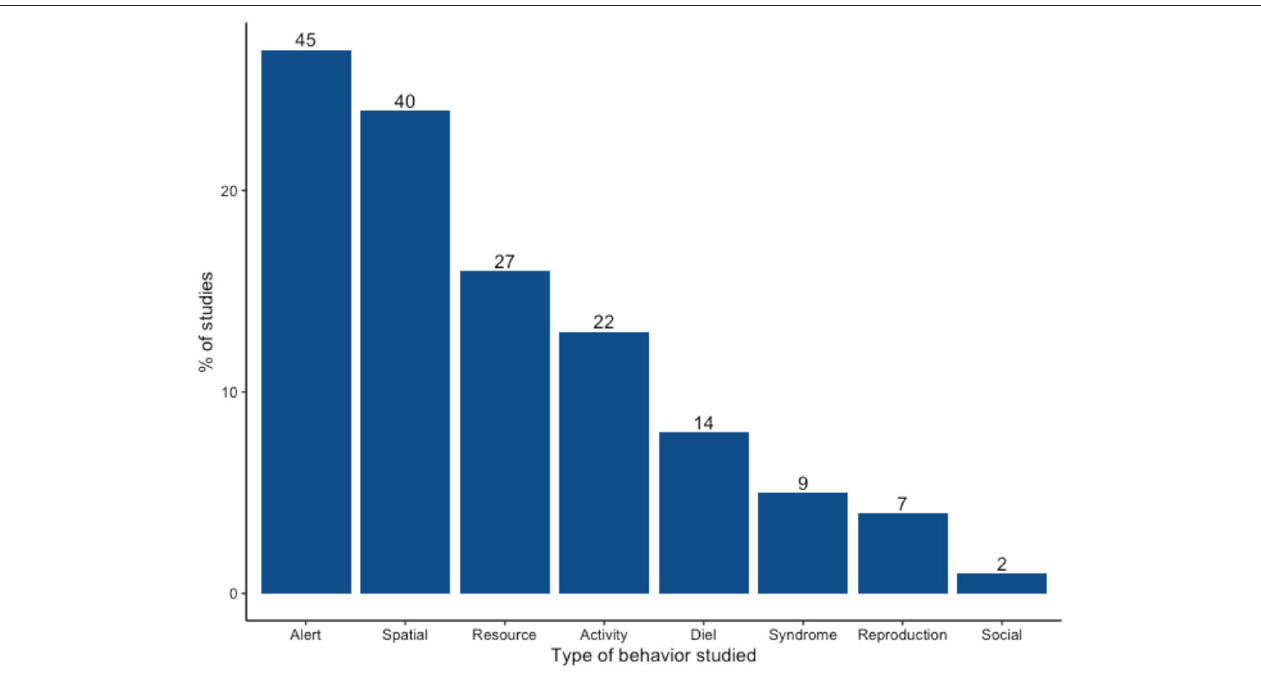
FIGURE 3 | Types of behavior changes studied in urban mammals between 1987 and 2020. Values above bars indicate the total number of observations studied within each behavior